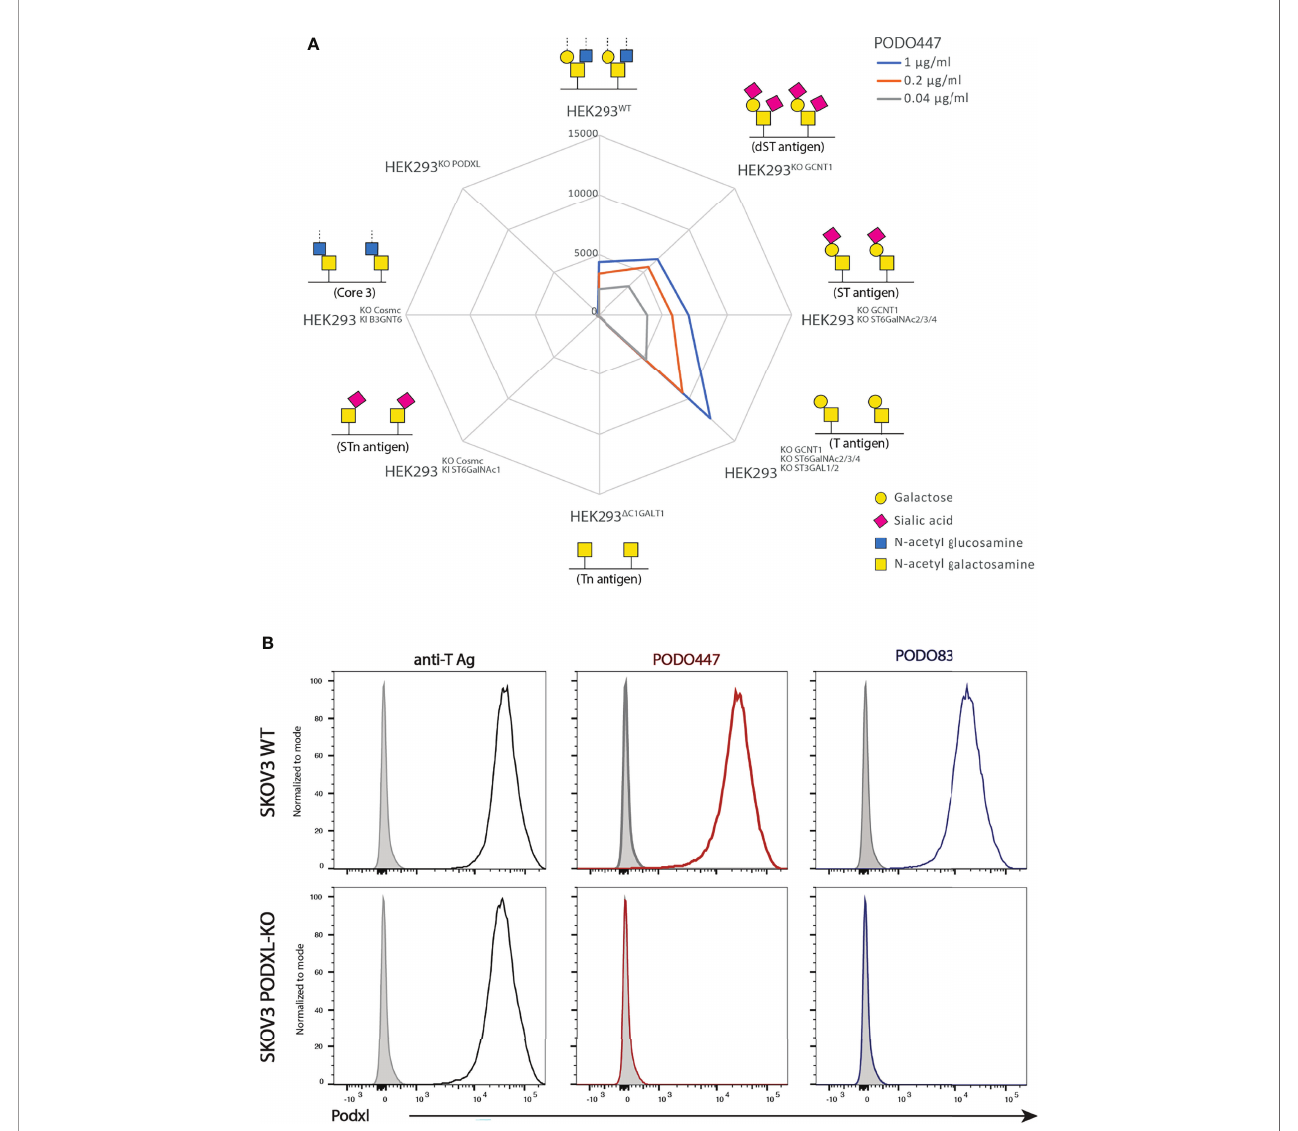
FIGURE 1 | PODO447 binds to a core 1 O-glycan structure on Podxl. (A) Isogenic HEK-293 cells bearing mutations in glycosyl transferases were stained with various concentrations of PODO447 and evaluated by fl ow cytometry. Mean Fluorescence Intensity (MFI) results are summarized in the “ spiderweb plot ” . (B) Flow cytometric anti-core 1 PNA lectin (black lines), PODO447 (red lines) and PODO83 (blue lines) binding pro fi les of SKOV3 WT and SKOV3 PODXL-KO